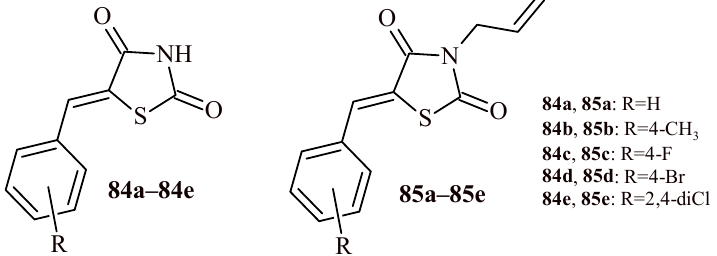
Figure 35. The 5-Arylidenethiazolidine-2,4-diones with α -amylase and α -glucosidase inhibitory ac- tivity.